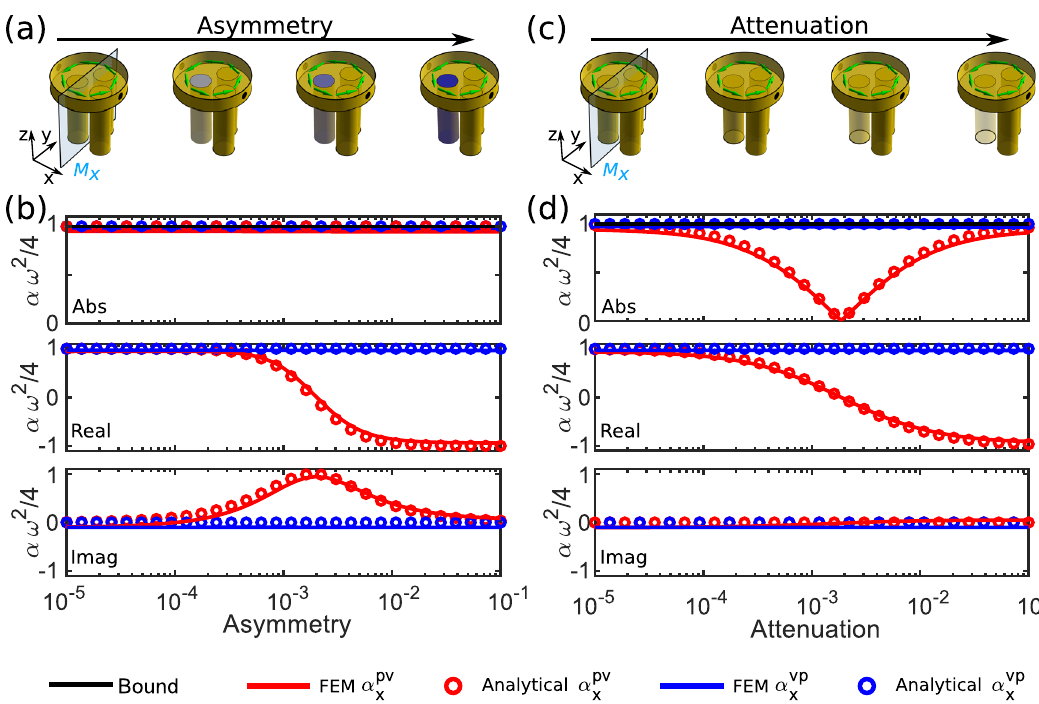
Fig. 3 Role of geometrical asymmetries and loss. a , b Evolution of the Willis coef fi cients as a function of geometrical asymmetry in the left cavity. c , d Evolution of the Willis coef fi cients as a function of loss in the left